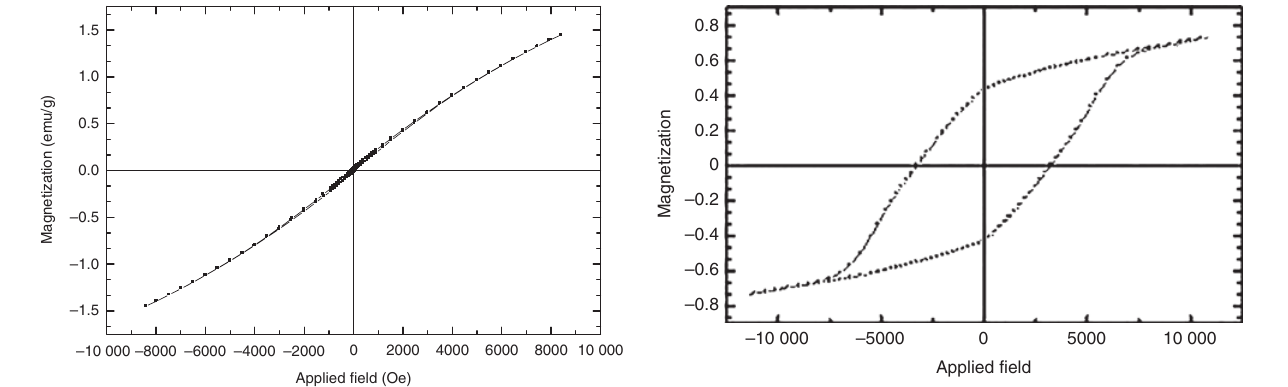
Figure 13: Room temperature hysteresis curve at 500 ° C.